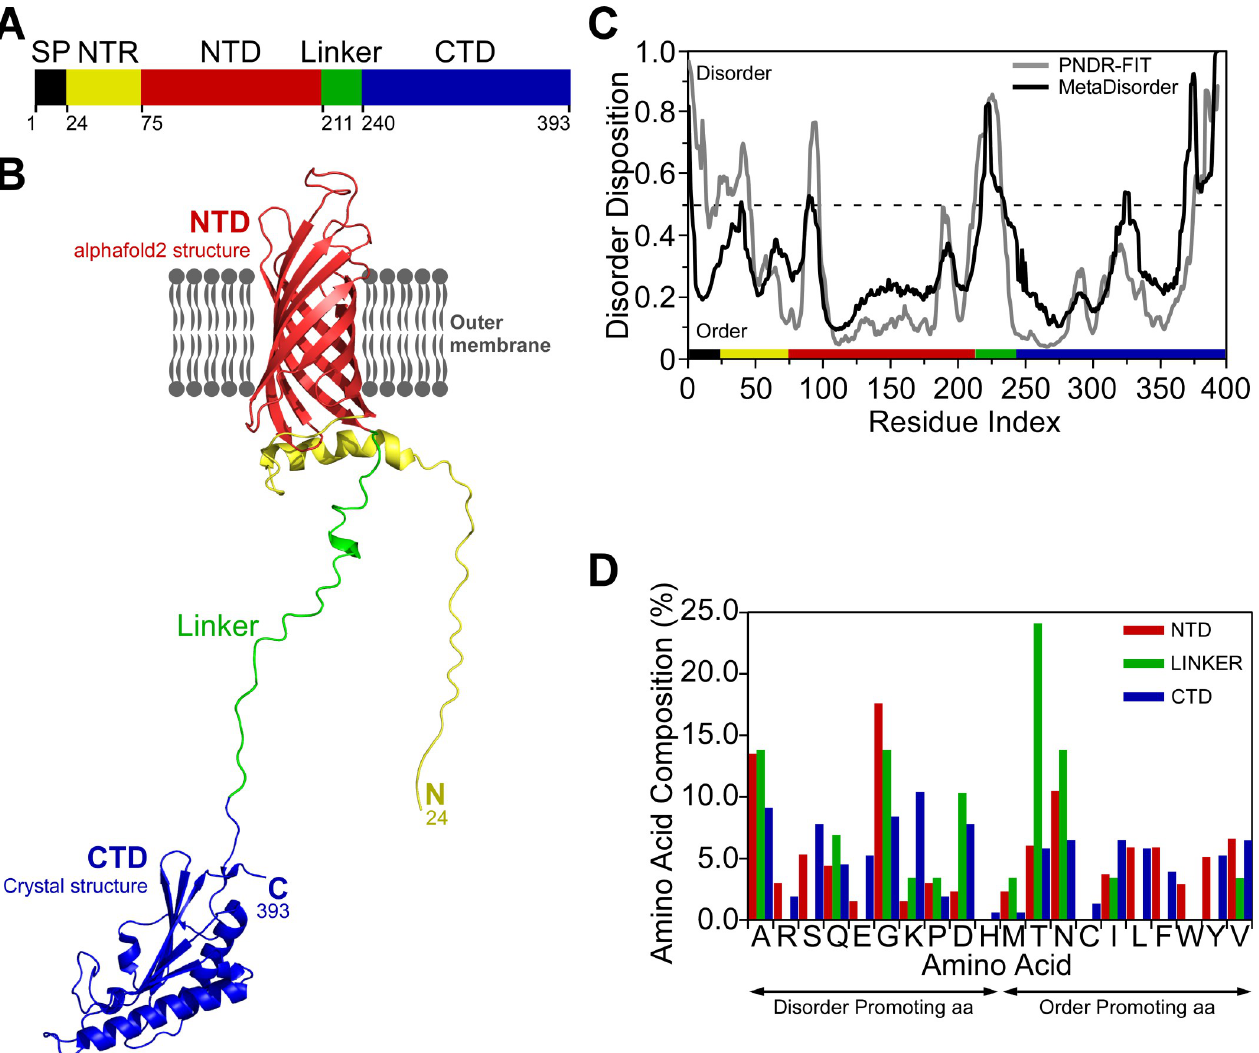
Fig 1. Structural analysis of FopA. (A) Domain organization of FopA. The colors of the domains are maintained in the subsequent panels. SP, signal peptide; NTR, N-terminal region; NTD, N-terminal domain; CTD, C-terminal domain. (B) Alphafold2 model of FopA-NTD (red) and crystal structure of FopA-CTD (blue) solved by Michalska and co-workers (PDB ID 6U83). The unstructured linker connecting the two domains is shown in green. (C) Prediction of disordered regions in FopA by two meta disorder prediction programs PONDR-FIT [63] and MetaDisorder [60]. (D) Comparison of the composition of each amino acid in the NTD, CTD and linker. Order and disorder promoting amino acids (aa) are indicated